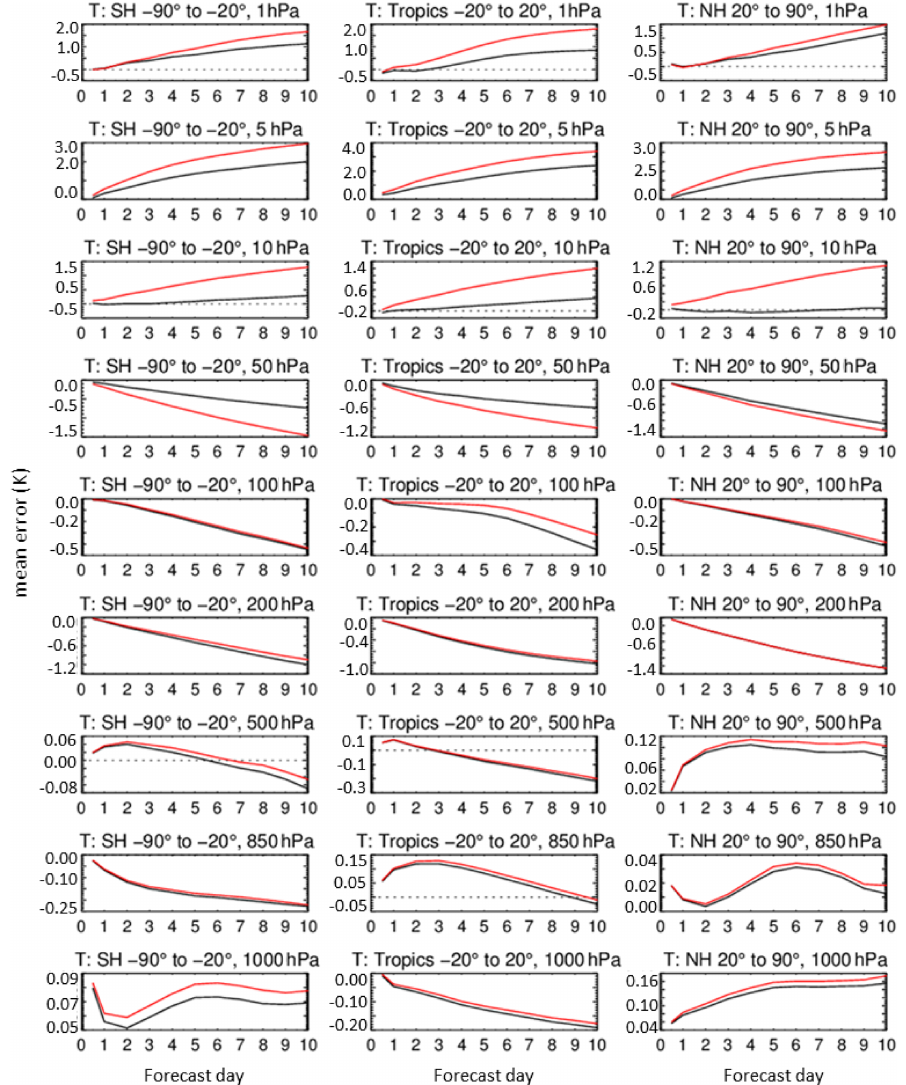
Figure 8. Mean error in the temperature field (K) compared to the operational ECMWF analyses, as a function of lead time for the forecast experiment using the new BMS ozone (black) and the one using the CD ozone (red), both with prognostic ozone interactive with radiation. The two model runs consist of 10d forecasts covering a 1-year period, from August 2012 to July 2013. The figure shows three latitudinal bands, 90–20 ◦ S (left column), 20 ◦ S–20 ◦ N (centre column) and 20–90 ◦ N (right column), for different pressure levels as labelled for each row, from 1.0 to